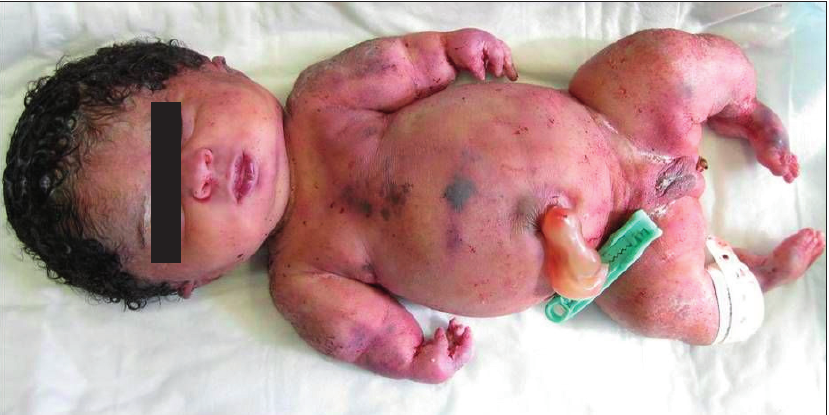
Fig. 1. A female fetus was stillborn at 34 weeks’ gestation, with a birth length less than the 3rd centile and an upper:lower segment ratio of 2.25 (increased). The following dysmorphic features were noted: soft skull, blue sclera, prominent beaked nose, small mouth, short upper limbs (both rhizomelic and mesomelic segments) and bowed lower